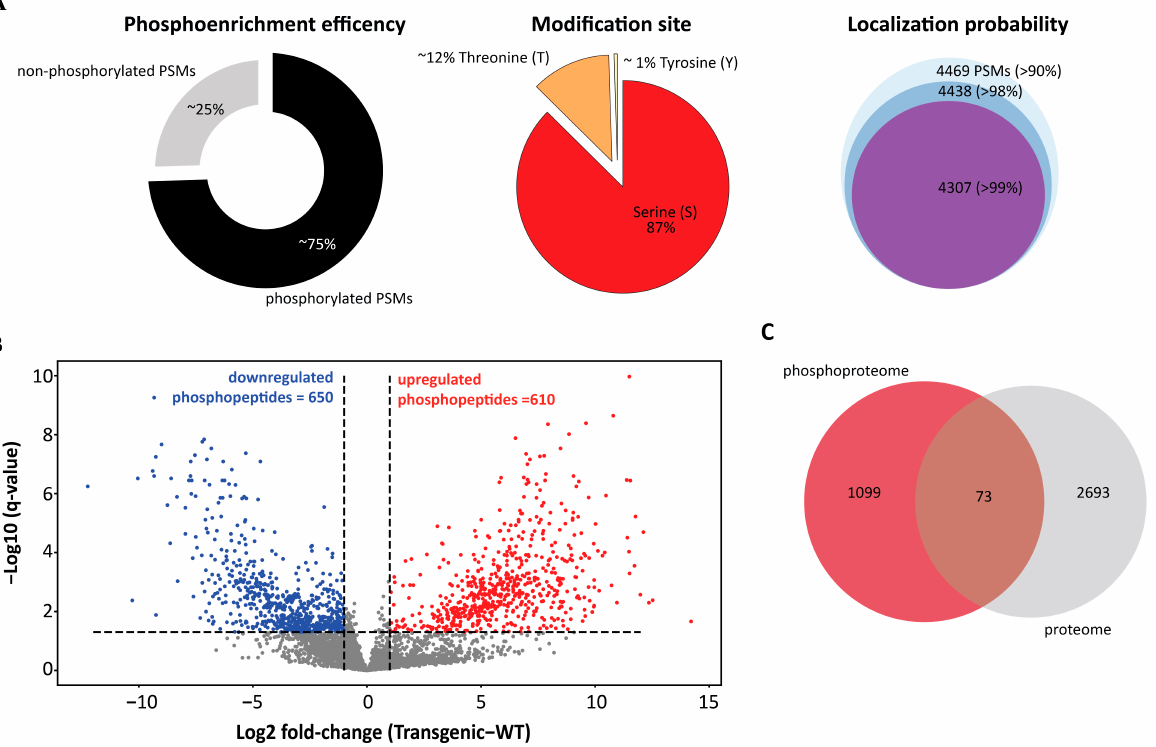
Figure 1. Qualitative and quantitative assessment of phosphoproteomics result from the root